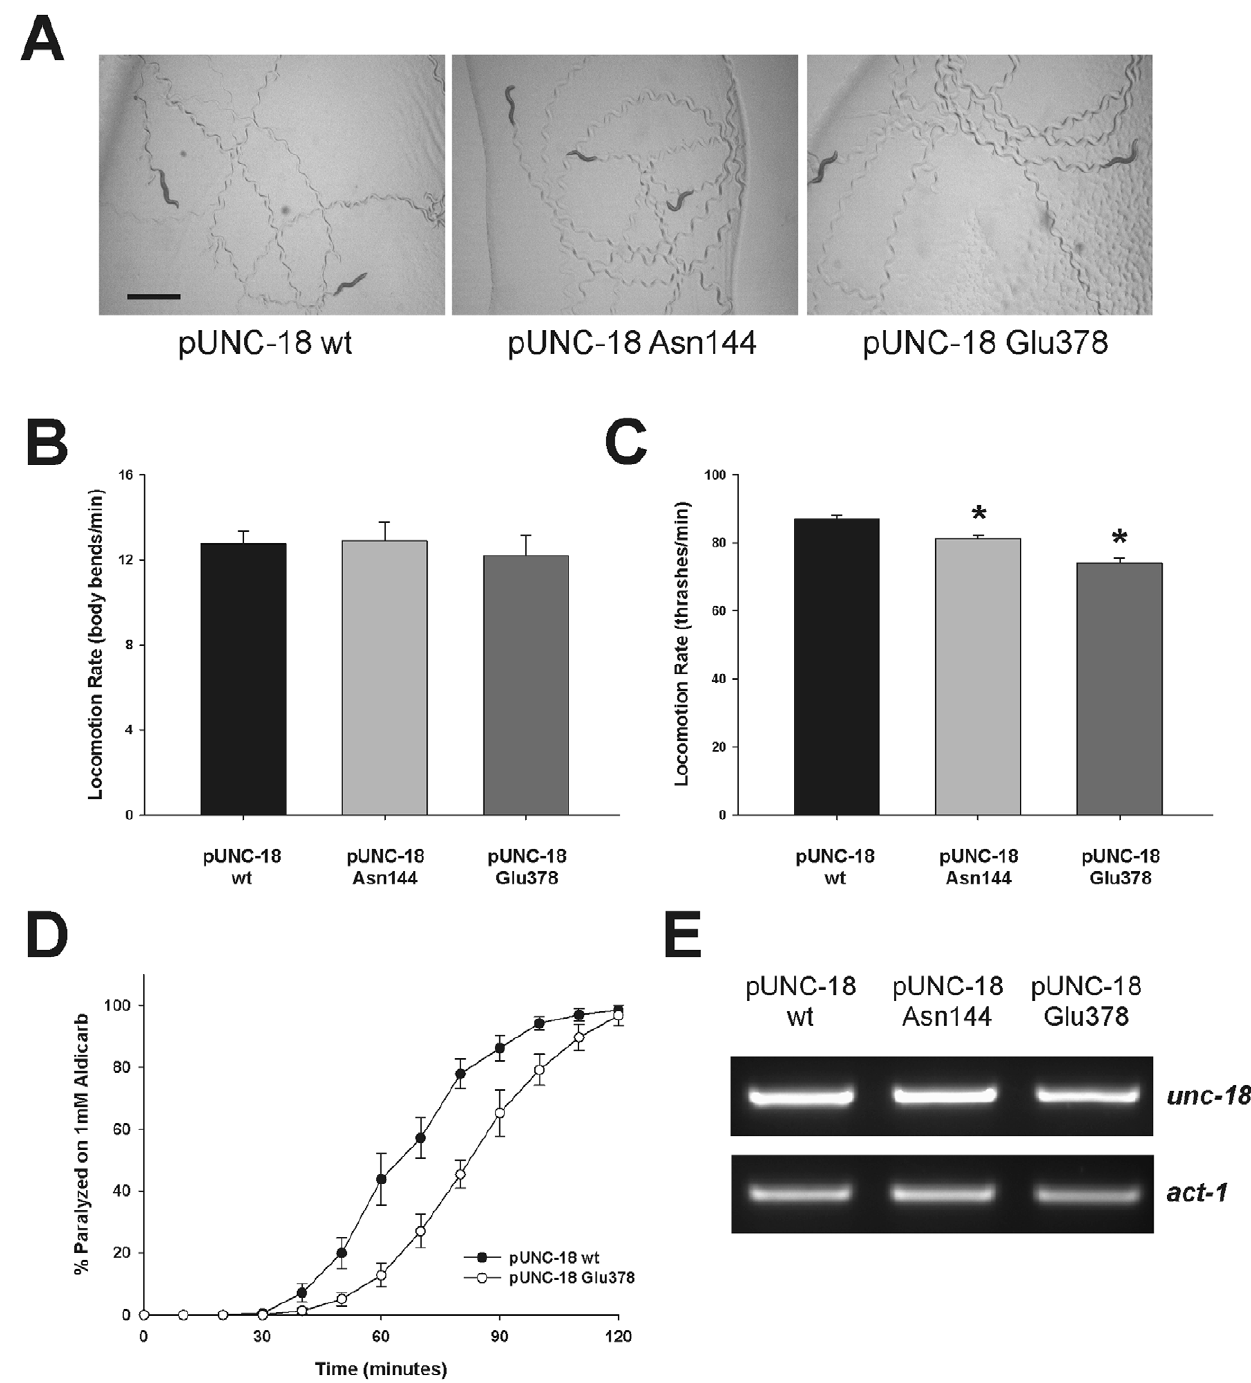
Figure 5. Transgenic Caenorhabditiselegans expressing the Glu378 insertion are resistant to the effects of aldicarb. (A) The unc-18 ( e81 ) null mutant was rescued with transgenic constructs expressing either wildtype (wt) UNC-18 or UNC-18 with the Asn144 or Glu378 insertion mutations. Photographs depict trails left in OP50 E. coli from 5 rescued worms after 5 minutes. Scale bar =1 mm. Locomotion rate for each transgenic rescue was then quantified by counting body bends per minute on unseeded solid agar (B) or by counting thrashes per minute in solution (C). There were no differences in locomotion rate between transgenic rescues on agar whereas both the Asn144 and Glu378 transgenic rescues moved slightly slower in solution (*; p , 0.01). Data were analysed from 50 pUNC-18 wildtype, 46 pUNC-18 Asn144 and 25 pUNC-18 Glu378 worms (body bends) and 124 pUNC-18 wildtype, 94 pUNC-18 Asn144 and 126 pUNC-18 Glu378 (thrashes). (D) The Glu378 insertion mutant was resistant to the effects of aldicarb in comparison to wildtype (wt) rescues. Experiments were performed on a population of 20-25 adult hermaphrodite worms exposed to 1 mM aldicarb. Onset of paralysis was determined by mechanical stimulation every 10 minutes following exposure to the drug. Data were analysed from at least 3 separate experiments and represent the responses of multiple independently-derived transgenic rescues. (E) mRNA expression of unc- 18 was not different in transgenic rescues with wildtype (wt) unc-18 , Asn144 or Glu378 mutants. Total RNA was purified from individual strains and used to generate cDNA. A similar level of amplification was achieved from all strains using plasmid-specific unc-18 primers. Amplification of actin ( act-1 ) was used as a control. doi:10.1371/journal.pone.0017999.g005 PLoS ONE |